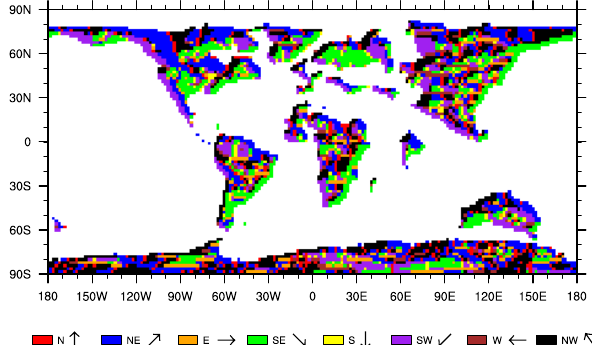
Figure 8. Eocene river runoff directions. Directions indicated by